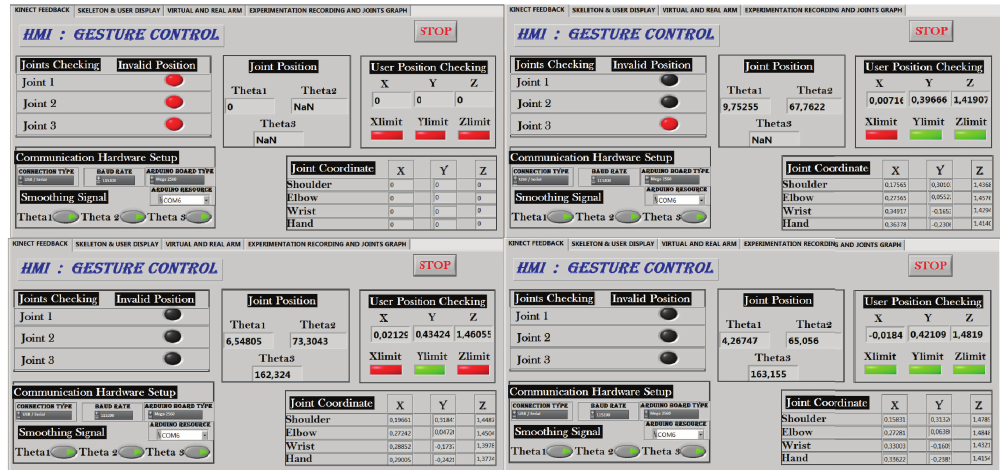
Figure 9: User position checking process.